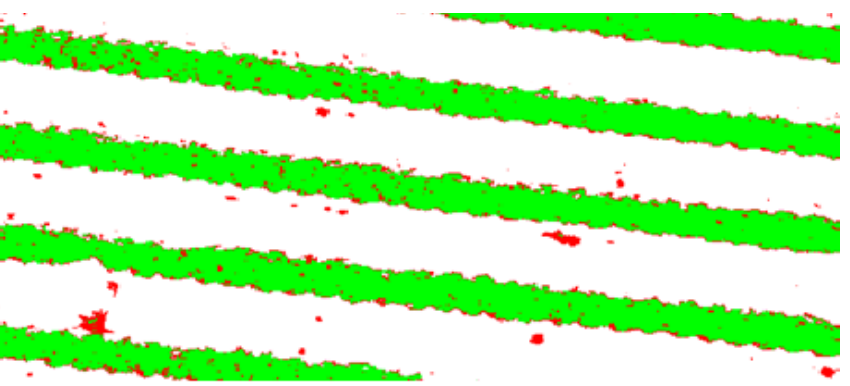
Figure 2. Labelled image to train the ML algorithms. (Crops are labelled in green, weeds are labelled in red and unwanted area is labelled as